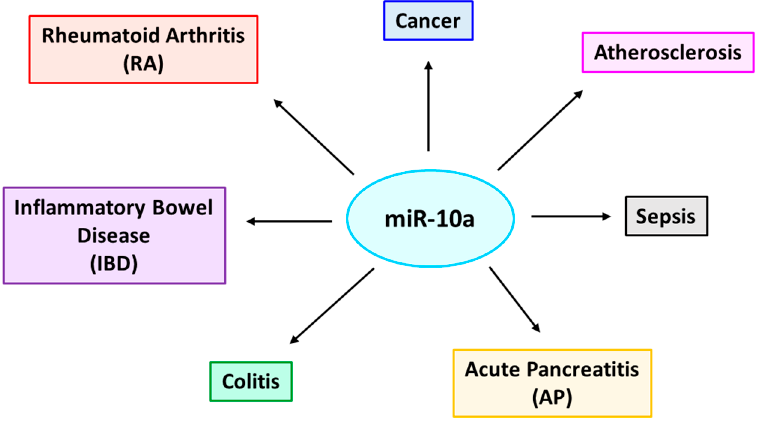
Figure 5. Various inflammation-associated diseases regulated by miR-10a. miR-10a is a key regulatory molecule that influences several inflammation-associated diseases, such as rheumatoid arthritis (RA), inflammatory bowel disease (IBD), colitis, acute pancreatitis (AP), sepsis, atherosclerosis, and cancer.